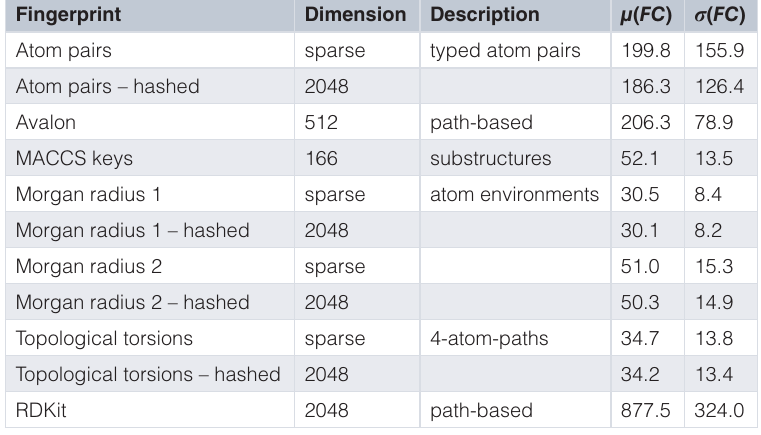
Table 1. Fingerprints available in